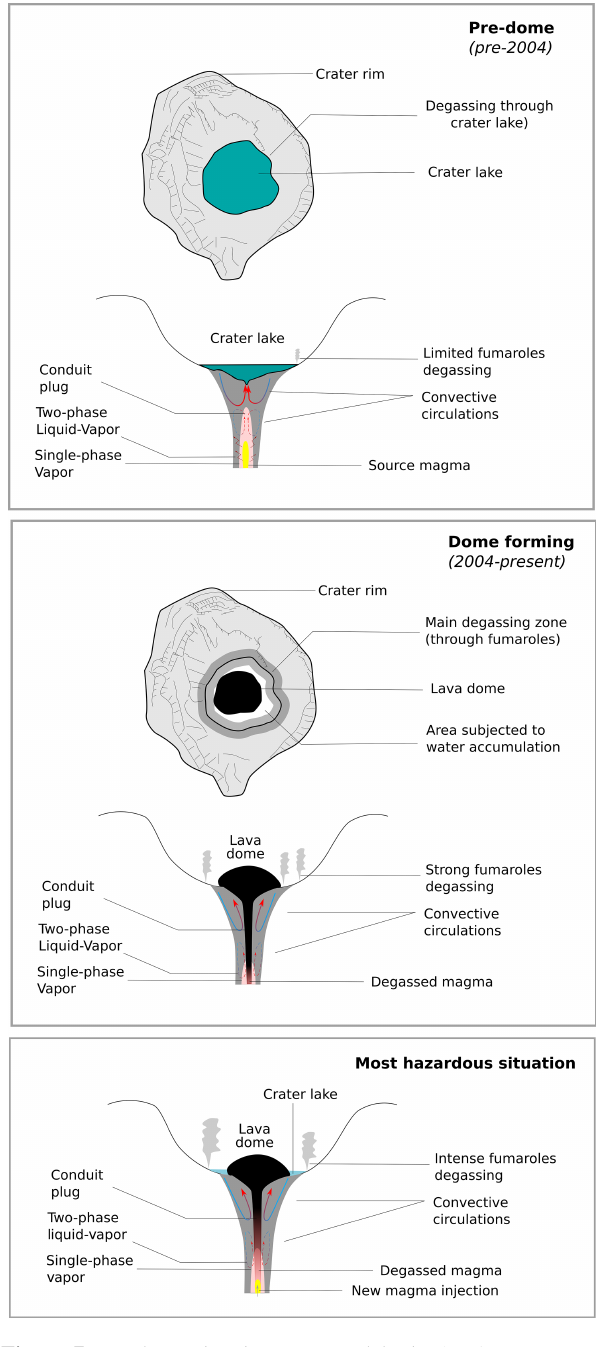
Figure 7. Pre-dome situation: a crater lake in Awu’s crater. Few fumaroles on the crater wall. Dome-forming situation: lava dome emerged at the surface leading to lake water dry out. Numerous fumaroles around the lava dome due to conduit plug. Most haz- ardous situation: the cooled lava dome allowed the formation of a new crater lake. The new magma injection may enhance the opening of the conduit plug, leading to subsequent explosive water–magma